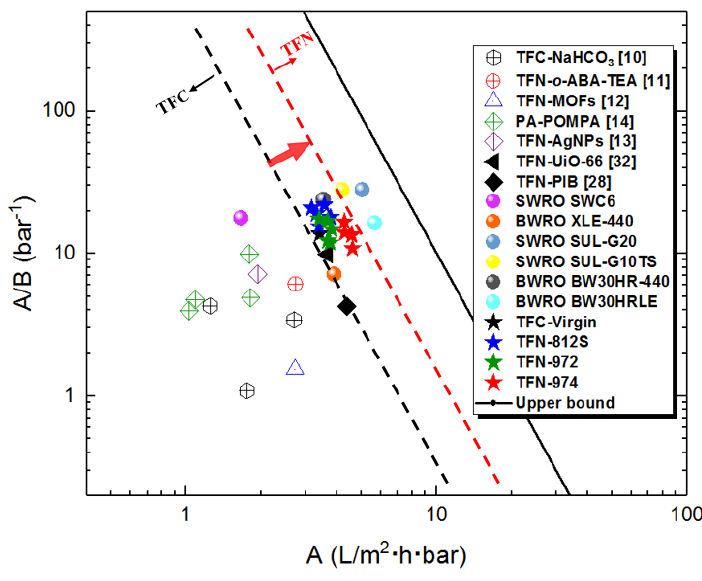
Figure 13. The performance comparison of RO membranes in this work with other RO membranes reported in the literature (including the commercial membranes in the reports). All membranes were tested using 2000 mg L − 1 NaCl feed solution under 16-bar pressure. While TFN-MOFs, TFN-AgNPs, TFN-UiO-66, and TFN-PIB were under 15.5 bar, and PA-POMPA was under 15 bar. TFN-o-ABA-TEA was tested at 32,000 mg L − 1 NaCl and operating pressure of 55 bar. The upper bound was based on the water/NaCl selectivity A/B and water permeability coefficient A for TFC polyamide membranes [48].